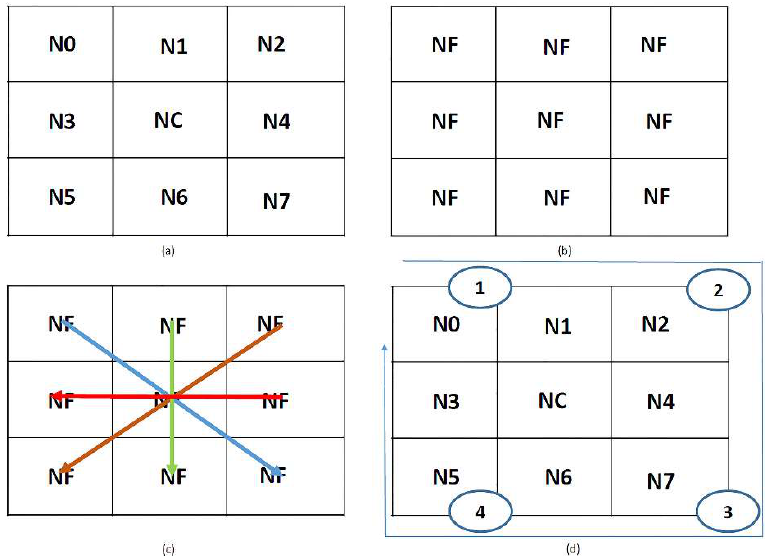
Figure 7. Image segmentation by PSO. ( a ) original image value; ( b ) the threshold image value; ( c ) make edge region; ( d ) rectangular area.